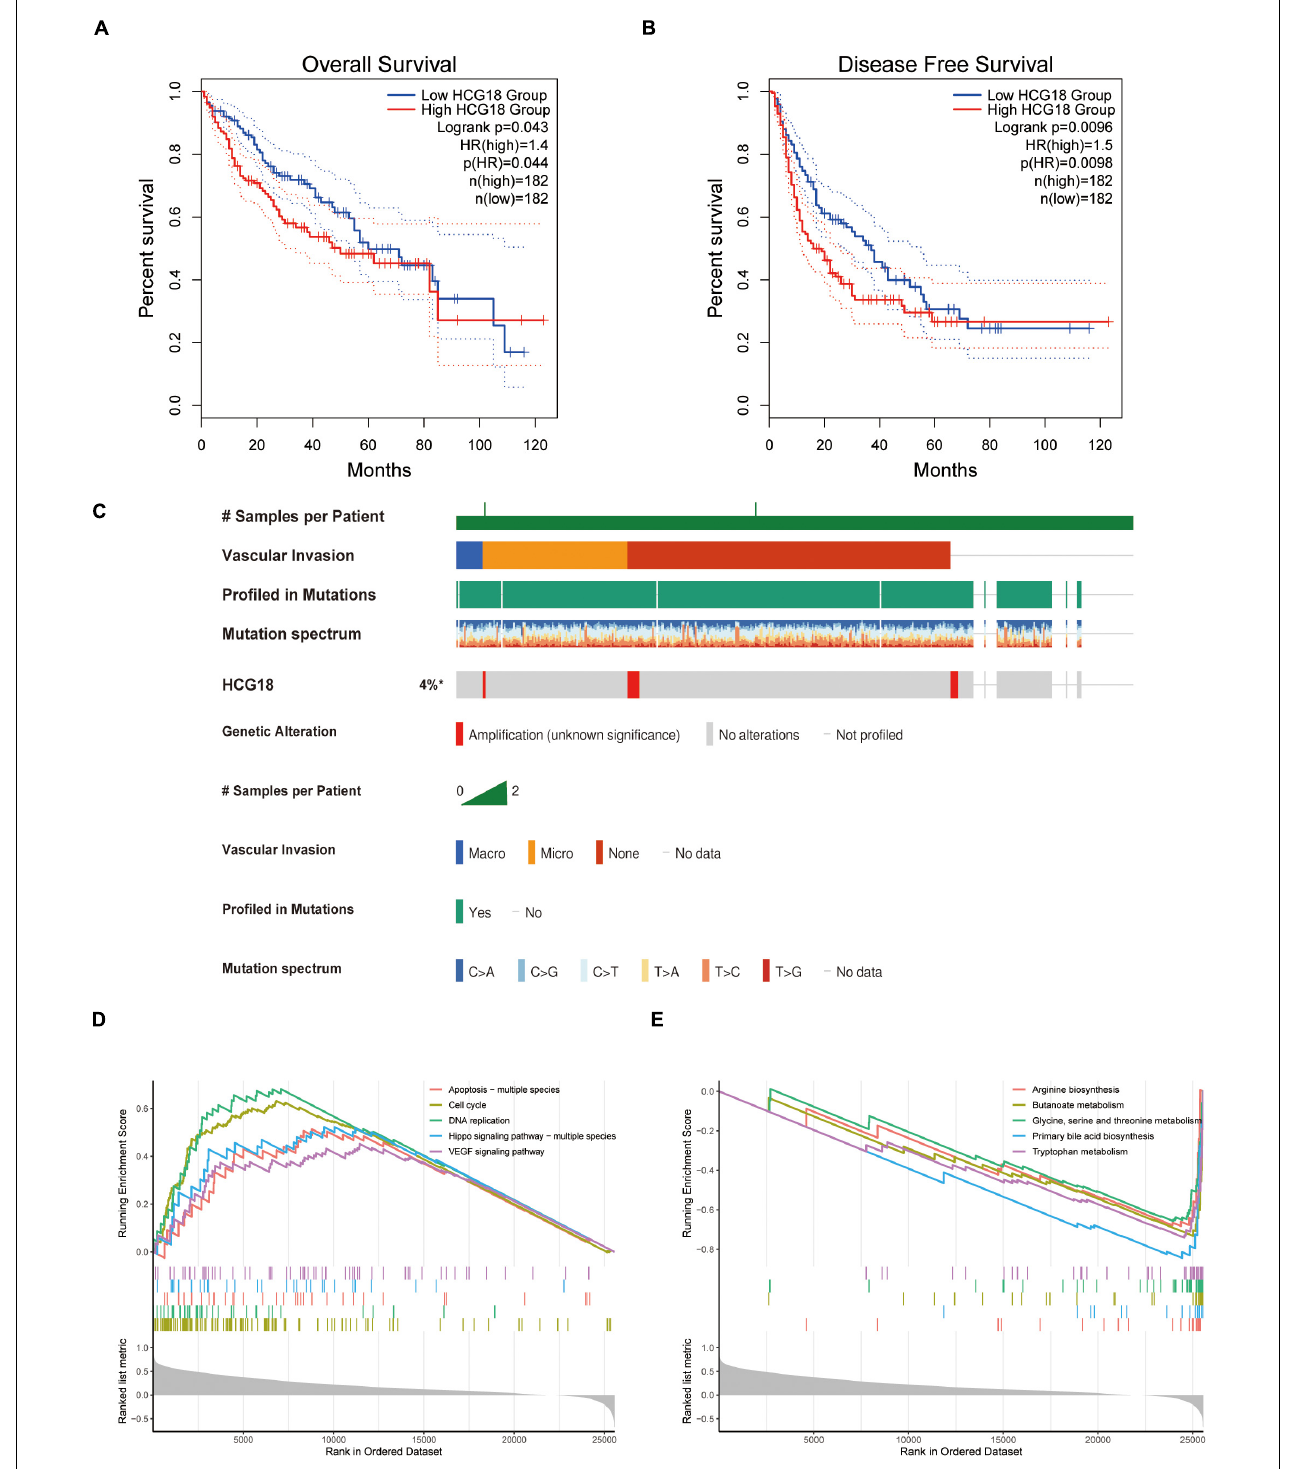
FIGURE 3 | Clinical, genomic and transcriptome characteristics of HCG18. (A) Overall survival analysis of HCG18. (B) Disease-free progression-free survival analysis of HCG18. (C) Single nucleotide mutations and copy number changes of HCG18 in HCC patients, ranked by vascular invasion. (D) GSEA analysis based on KEGG; an enrichment score greater than 0 represents a pathway that increases expression of HCG18 after high expression. (E) An enrichment score less than 0 represents a pathway of decreased HCG18 expression after high HCG18 expression. In GSEA analysis, P < 0.05 was used as the criterion to screen for significantly altered pathways. *The amplification of HCG18 in HCC was statistically